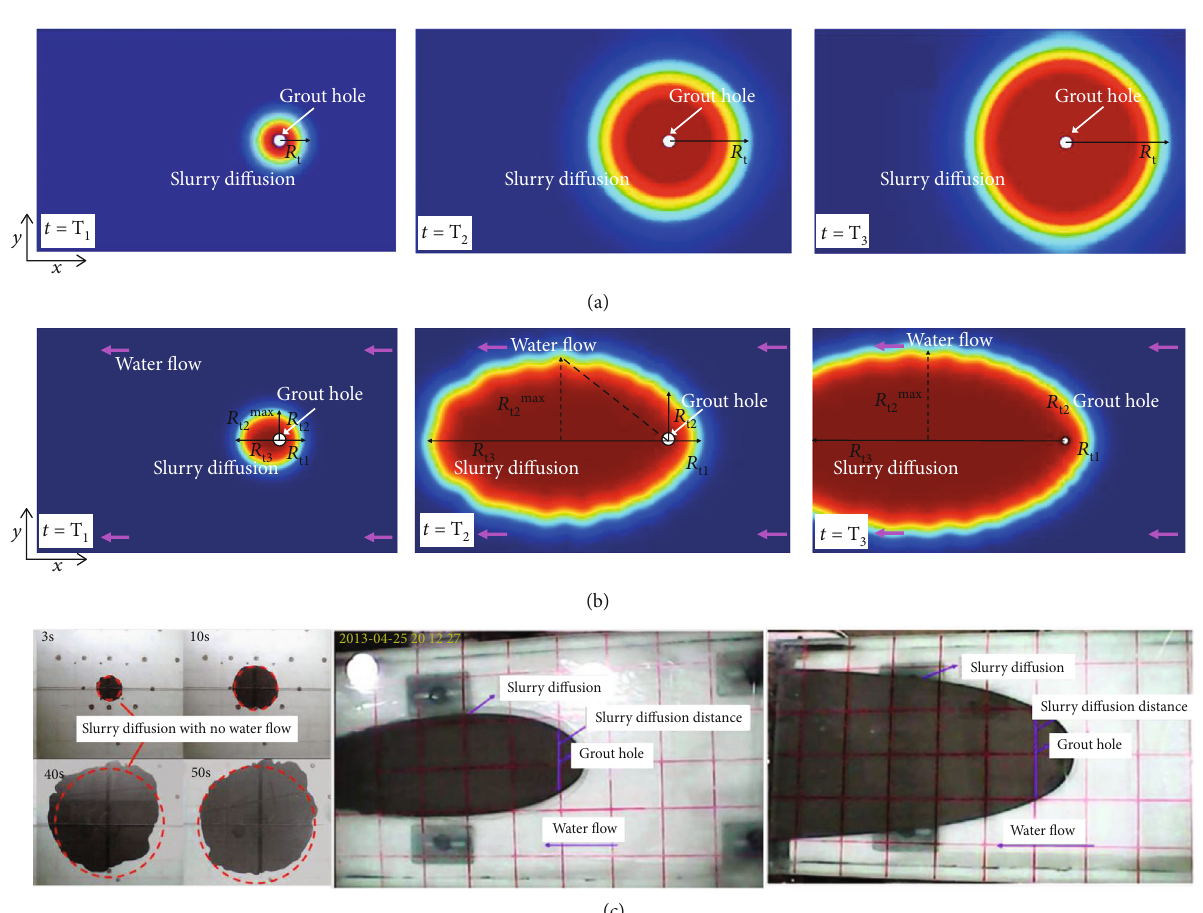
Figure 6: Numerical calculation and experimental veri fi cation of slurry di ff usion. (a) Simulation of no water fl owing. (b) Simulation of water fl owing. (c) Experiment of slurry di ff usion [43,